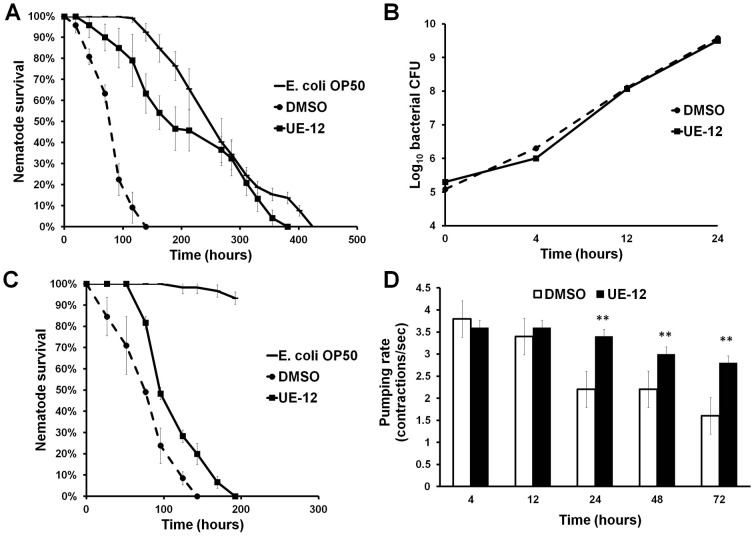
UE-12 enhances the survival of S. aureus-infected nematodes without interfering with bacterial growth.(A) S. aureus infection assay on wild-type N2 nematodes exposed to 200 µg/mL of UE-12 compared to untreated control exposed to solvent (DMSO) only. UE-12 confers significant lifespan extension in infected nematodes (p<0.0001). Graph shows the mean ± SD of six replicates (20 nematodes/replicate) from a representative of three independent assays. (B) UE-12 does not inhibit the growth of S. aureus in the same medium used for C. elegans infection assay, comprising 80% M9 buffer and 20% S. aureus culture. Data are the average of three independent experiments with error bars representing the standard error of the mean. (C) S. aureus infection assay on wild-type N2 nematodes pre-treated with 200 µg/mL of UE-12 for 24 hours compared to untreated control exposed to solvent (DMSO) only. The worms pre-treated with UE-12 were then infected with S. aureus in the absence of extract. The survival curves indicate significantly enhanced survival over time in UE-12-treated worms as compared to the control (p<0.0001). Graph shows the mean ± SD of six replicates (20 nematodes/replicate) from a representative of three independent assays. (D) No significant difference in pharyngeal pumping rates is observed for the first 4 and 12 hours. The pumping rates of untreated animals are significantly lower than the UE-12-treated animals after 24, 48 and 72 hours infection. The bars correspond to mean ± SD of the contractions/second from one representative of two individual replicates. **A significant difference between untreated (DMSO) and treated worms (p<0.001).